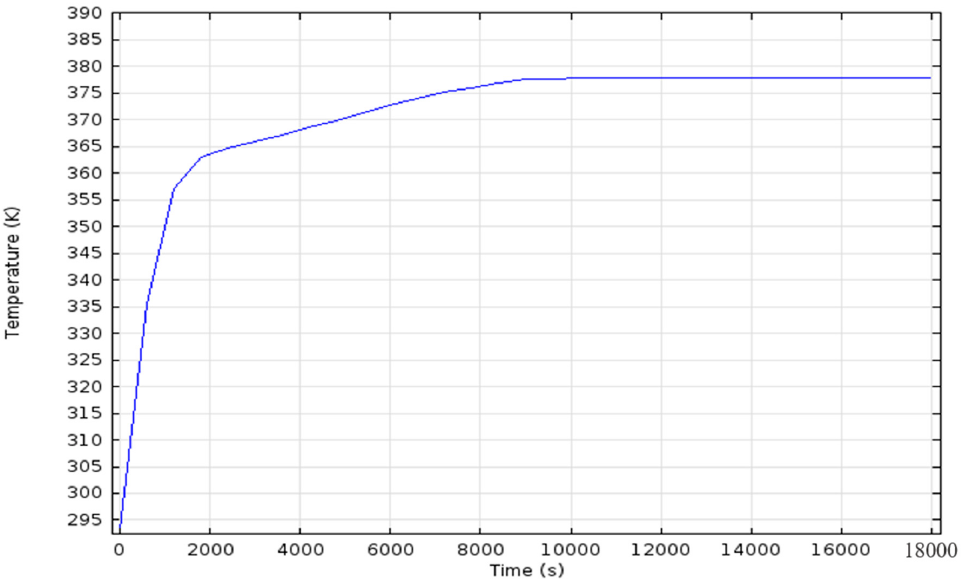
Figure 3. Temperature vs. Time of melting of the PCM.